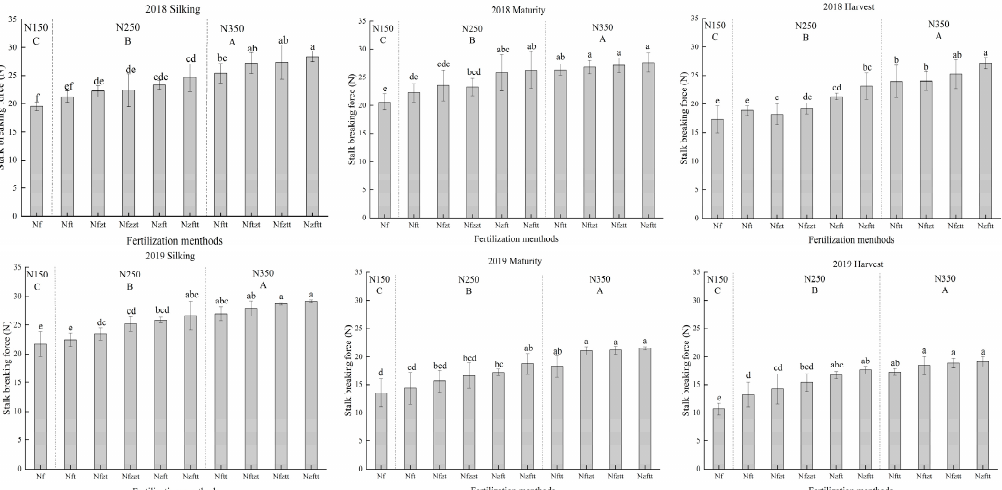
Figure 1. Effect of fertilization methods on cellulose and lignin contents of the third elongation internode at harvest stage under different nitrogen application rates. N150, N250, and N350 refer to the nitrogen application rate were 150, 250, and 350 kg ha − 1 , respectively. “z” refers to the nitrogen application rate being zero, “f” refers to the nitrogen application rate being 150 kg ha − 1 , “t” refers to the nitrogen application rate being 100 kg ha − 1 , e.g., Nf refers to nitrogen application rate being 150 kg ha − 1 at sowing stage; Nfzt refers to nitrogen application rate being 150, 0, and 100 kg ha − 1 at sowing, 6-leaf, and 12-leaf stages, respectively; Nzftt refers to the nitrogen application rate being 0, 150, 100, and 100 kg ha − 1 at sowing, 6-leaf, 12-leaf, and silking stages, respectively. Capital letters indicate a significant difference at the p < 0.05 level under different nitrogen application rates. Lowercase letters indicate a significant difference at the p < 0.05 under all treatments.